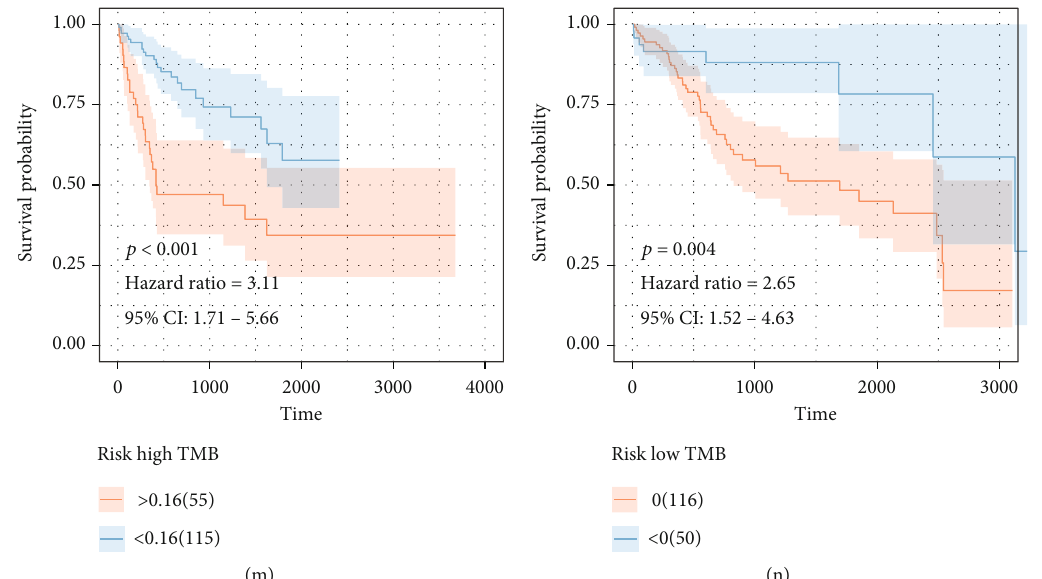
Figure 7: Cox regression analysis based on these CD8+ T cell-related genes. (a) The patients in the higher risk group showed worse outcome levels. (b) The receiver operating characteristic curve of the risk score in TCGA-LIHC cohort. (c – n) The subgroup survival analysis of CD8+ T cell-related gene risk scores.